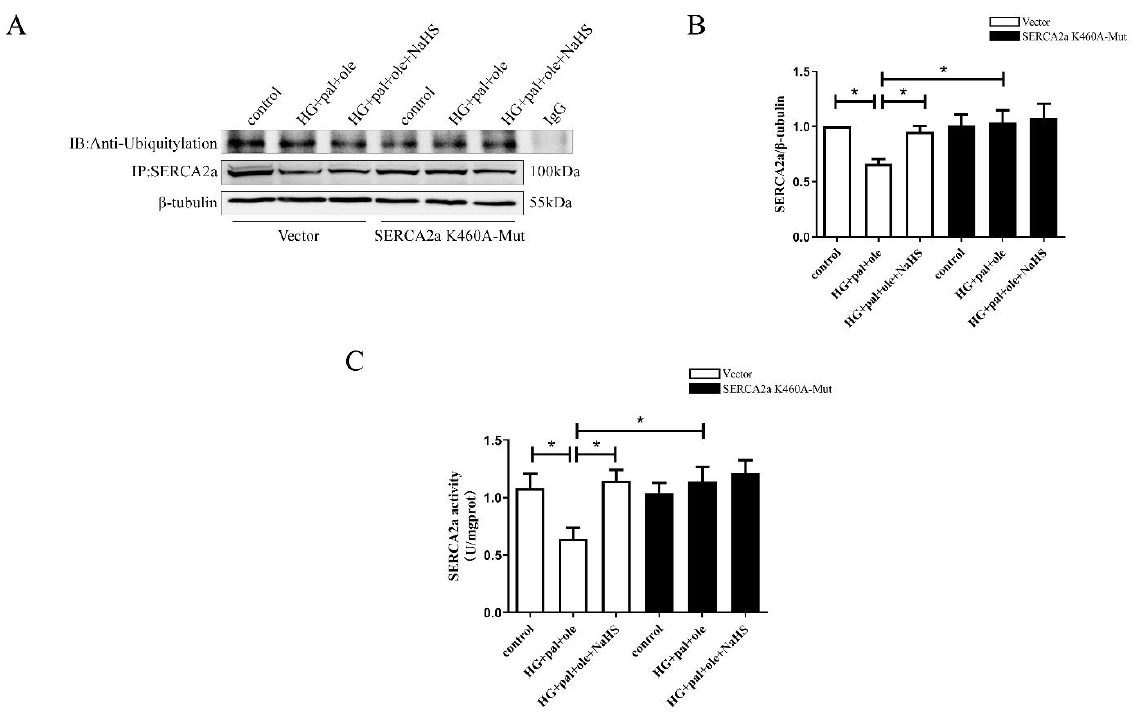
Figure 4. Exogenous H 2 S downregulated SERCA2a ubiquitylation at Lys460. After transfection with plasmids containing wild-type SERCA2a or SERCA2a mutated at Lys460 for 24 h, the NRCMs were treated with high glucose, palmitate, and oleate for 48 h in the presence or absence of NaHS. ( A ) The NRCMs were immunoprecipitated with an anti-SERCA2a antibody and then immunoblotted with antibodies specific for Ubiquitylation after transfection. ( B ) The expression of SERCA2a was assessed by Western blotting in the NRCMs after transfection ( n = 7). ( C ) The results of SERCA2a activity in the NRCMs after transfection ( n = 6). All values are presented as means ± standard errors, * p < 0.05.